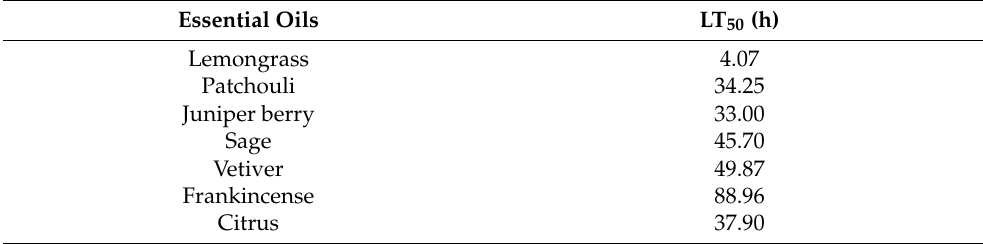
Table 2. Median lethal time of Panonychus citri treated with essential oils of 16 µ